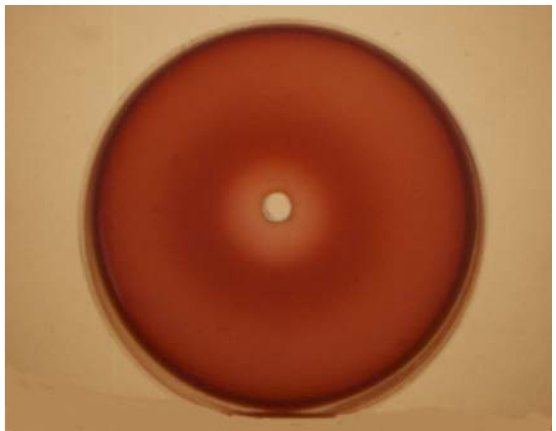
with CTAB followed by ruthenium red, although the clear zones were more conspicuous with the latter.